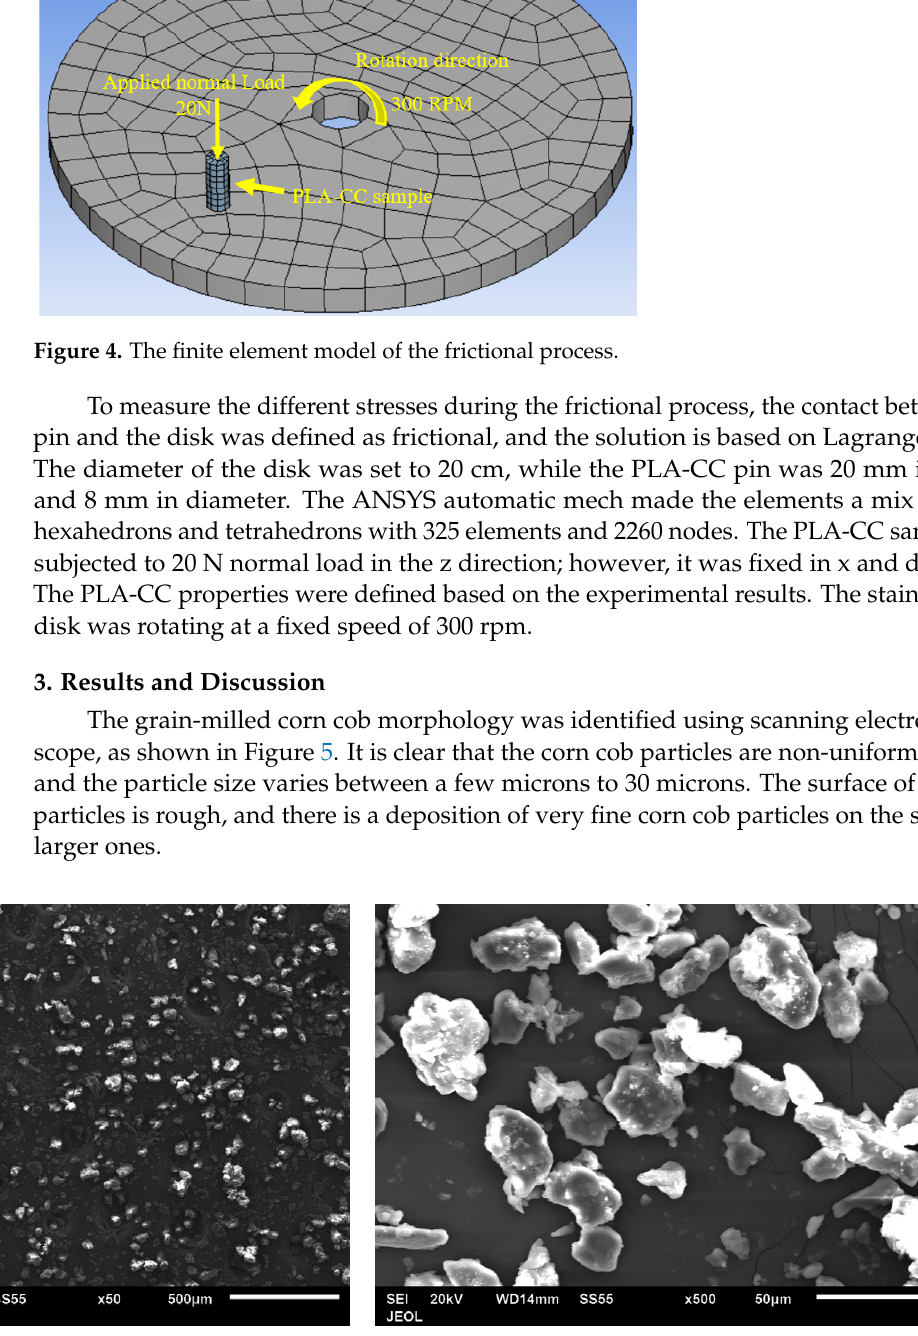
Figure 5. SEM image of grain milled corn cob particles.